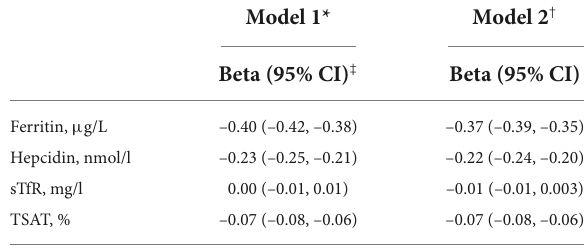
TABLE 3 Association of sex with iron